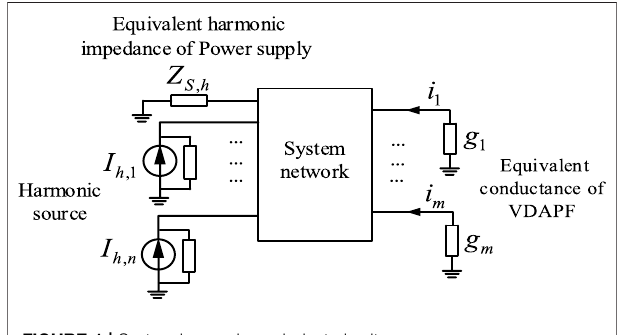
FIGURE 1 | System harmonic equivalent